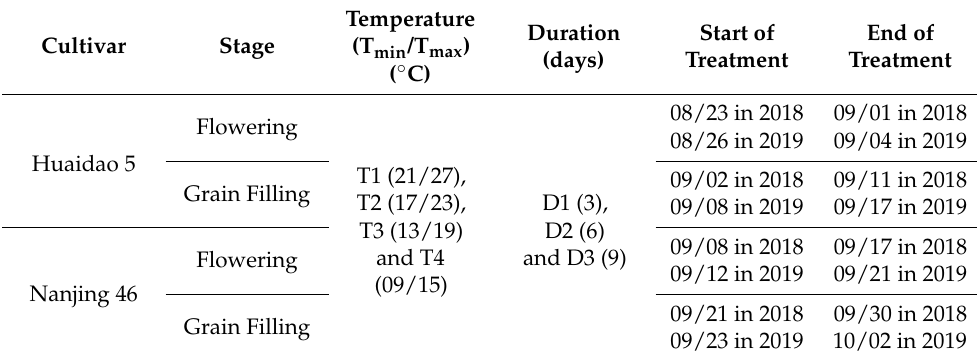
Table 4. Summary of the post-heading low-temperature stress treatments. Temperature Duration Start of Cultivar Stage (T min /T max ) (days) ( ◦ C) Flowering Huaidao 5 T1 (21/27), T2